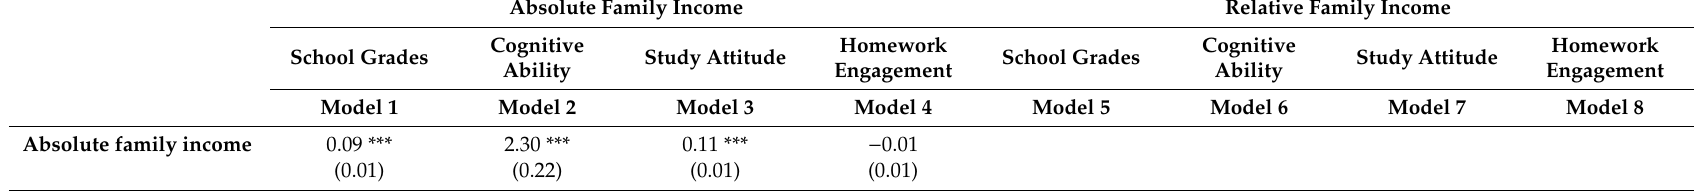
Table 2. The Associations between Family Income and Cognitive and Educational